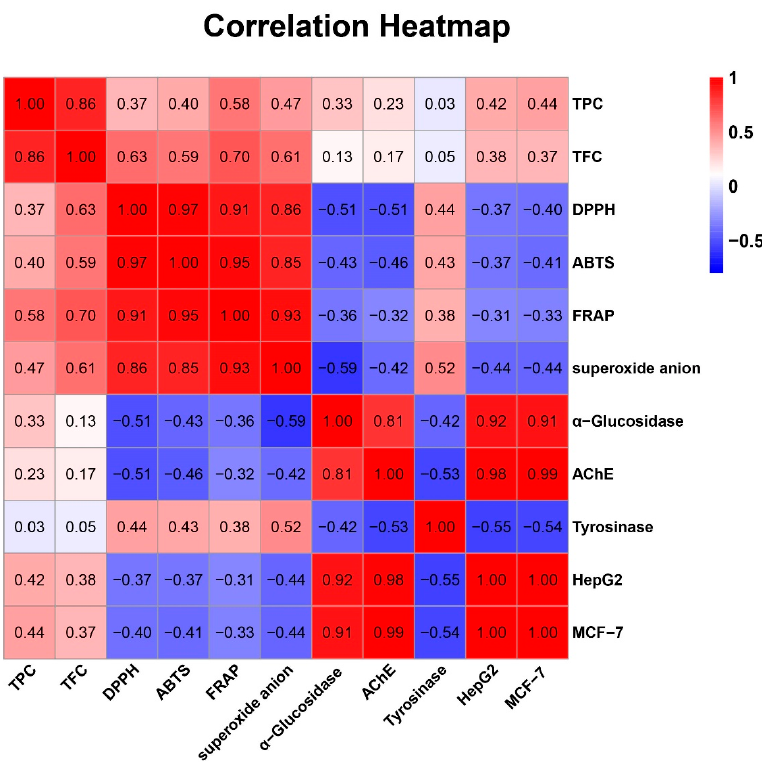
Figure 1. Results of correlational analyses from experiment. The Pearson coefficient ( r ) is given for each correlation in the corresponding color, and the p value represented as a heatmap ranging from − 1 to 1 (red to blue). TPC = total phenolic content; TFC = total flavonoid content; DPPH = DPPH·scavenging activity; ABTS = ABTS· + scavenging ability; FRAP = ferric reducing antioxidant power; superoxide anion = superoxide anion scavenging activity; α -Glucosidase = the IC 50 value for α -glucosidase inhibitory; AChE = the IC 50 value for acetylcholinesterase inhibitory activity; Tyrosinase = the IC 50 value for tyrosinase inhibitory; HepG2 = the IC 50 value for inhibition on HepG2 cell proliferation; MCF-7 = the IC 50 value for inhibition on MCF-7 cell proliferation.